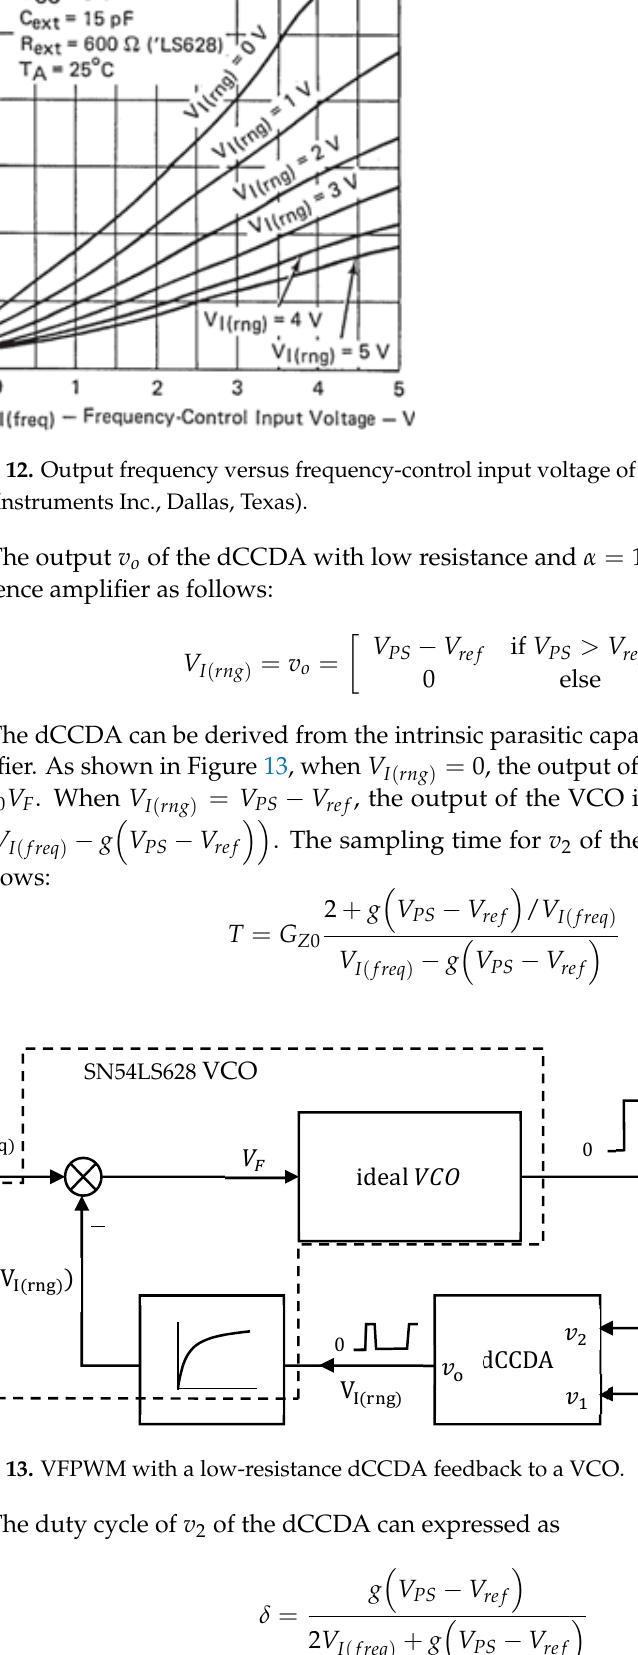
14 of 25 Figure 11. Block diagram of the dCCDA. The function of a practical VCO, such as the IC-SN54LS628, as shown in Figure 12 as an example, can be simplified into the following expression: 𝑓 (cid:3042) = 𝐺 (cid:3027)(cid:2868) (𝑉 (cid:3010)((cid:3033)(cid:3045)(cid:3032)(cid:3044)) − 𝑔(𝑉 (cid:3010)((cid:3045)(cid:3041)(cid:3034)) ))